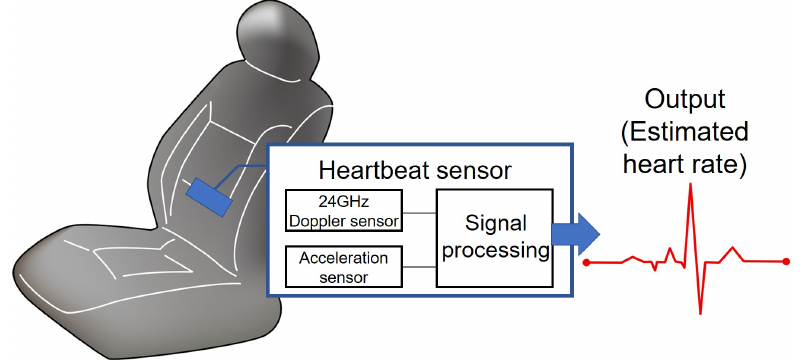
Figure 4. The outline of Mitani’s